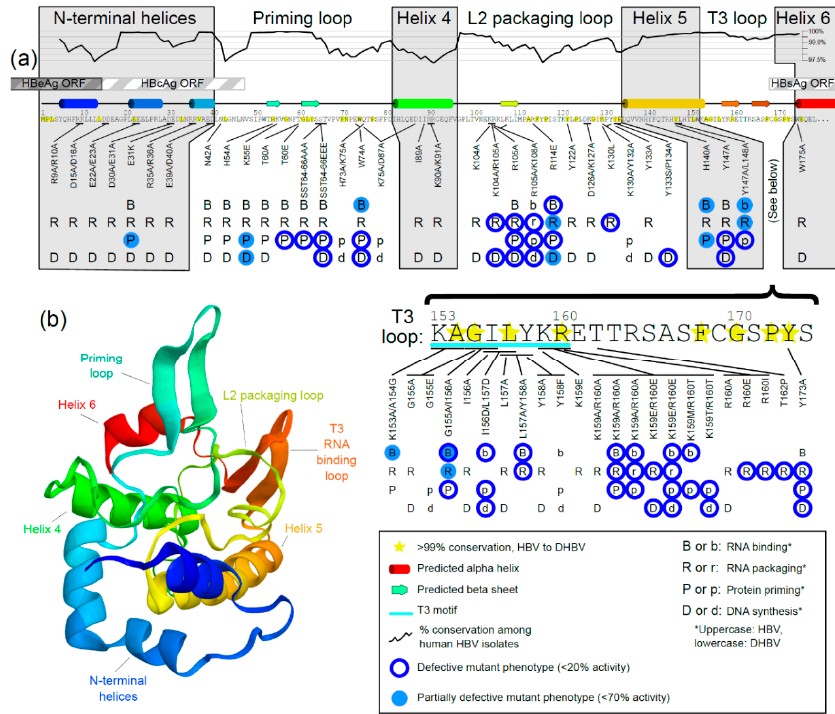
Figure 4. Two-dimensional and three-dimensional interactions of the terminal protein (TP) domain of the hepatitis B virus (HBV) polymerase protein. ( a ) Amino acid sequence for the TP domain, numbered according to genotype D. Overlap with other open reading frames (ORF) is indicated by striped bars. The TP domain is grouped into seven subdomains according to secondary structure predictions, with the helical regions in gray boxes. All known HBV (uppercase) and duck HBV (lowercase) mutants that have been tested are marked to represent the four tested functions. If a letter is absent, the mutant was not tested in that assay. Defective phenotypes are highlighted by blue circles representing either an extensive loss of function ( < 20% activity) or partial loss of function ( < 70% activity), whereas mutants exhibiting a wild-type phenotype are not circled. The T3 motif has been extensively tested in mutational studies. Yellow stars show TP domain residues with > 99% homology to duck HBV (DHBV). Homology among human samples is graphed above the sequence (black line), where peaks indicate regions of high homology. Homology is shown as percent conservation, a moving average of amino acid homology among 584 isolates of human HBV in 11 bp windows (five amino acids upstream and downstream from each position). ( b ) The three-dimensional structure of TP as predicted using QUARK. The seven predicted subdomains of TP are indicated and color-coded. The functional loop subdomains extend